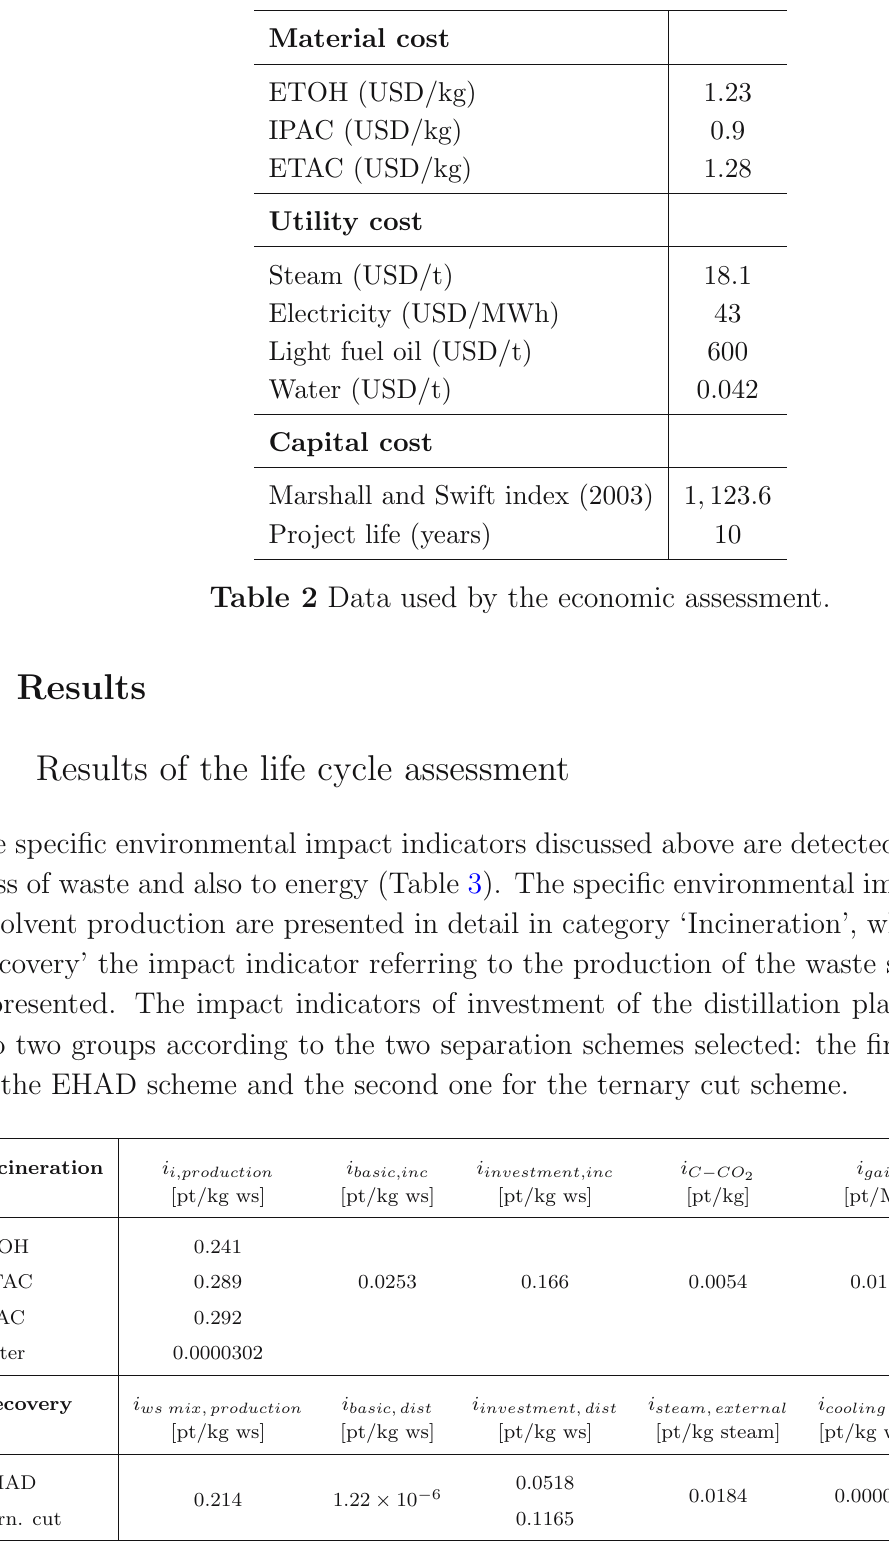
Table 3 Impact factors applied by the calculation of the Eco-indicator